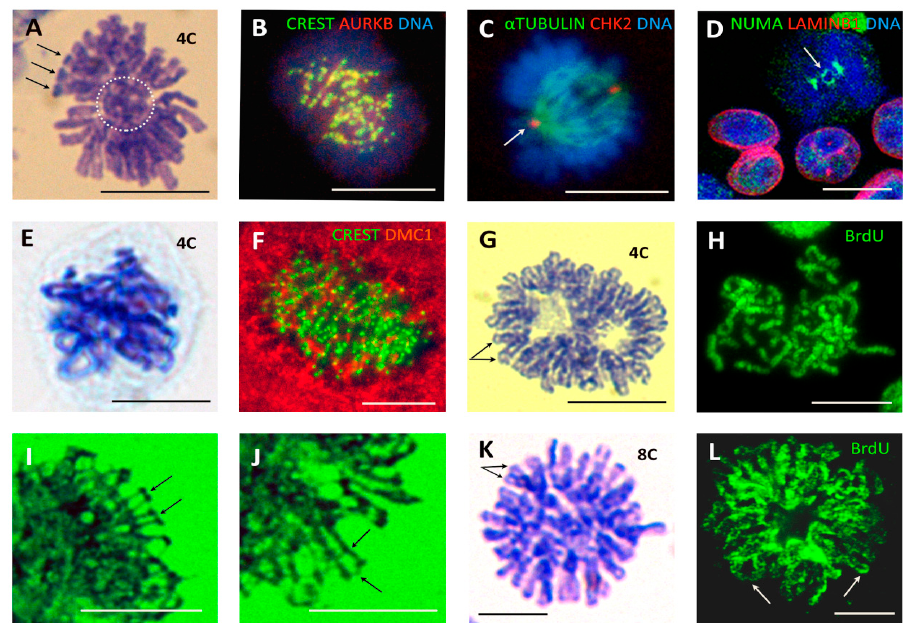
Figure 2. The non-conventional cell division patterns creating polyploidy: 4C PM segregating two ‘buttoned’ groups of dyads and 8C ‘bi-looped metaphases’ (BLM), observed in untreated germ-cell cancers and various somatic tumour cell lines and enhanced after genotoxic or spindle insults. ( A – D ) PM in the non-treated ovarian embryonal carcinoma PA1: ( A ) Two separated groups of bi-nemic chromosomes with connected telomere ends (arrowheads) and a central chromosome ‘button’ (dashed circle) in a cell with 4C DNA content (determined cytometrically, for details, see Methods). ( B ) Two groups of dyads in a PM showing centromere doublets (green CREST stain for kinetochores) colocalising with AURBK (yellow). ( C ) A misoriented spindle (with an asymmetrically stronger left pole) aligned perpendicularly to the axis of two closely opposed chromosome groups. ( D ) In PM, NUMA encircles the central DNA ‘button’ (arrow) connecting the two opposed chromosome groups.